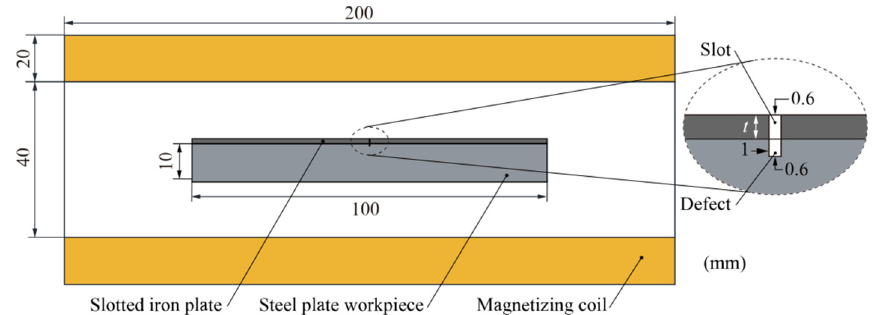
Figure 11. Two-dimensional simulation model of the SFLL-MFL method. Table 2. The parameters of the 2D simulation